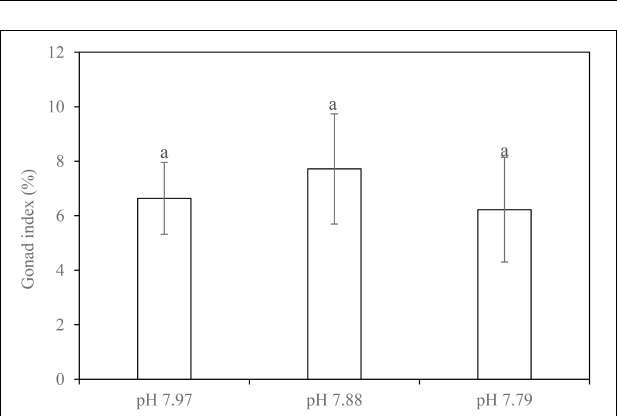
FIGURE 2 | Percentage of individuals that expelled Cuvierian tubules of the sea cucumber H. forskali attacked using crab claw at week 21 when exposed to pH 7.97, 7.88, and 7.79 levels. Data (expressed as mean ± SEM, n = 3) with different letters identifies statistically significant differences (Tukey HSD, p < 0.05).